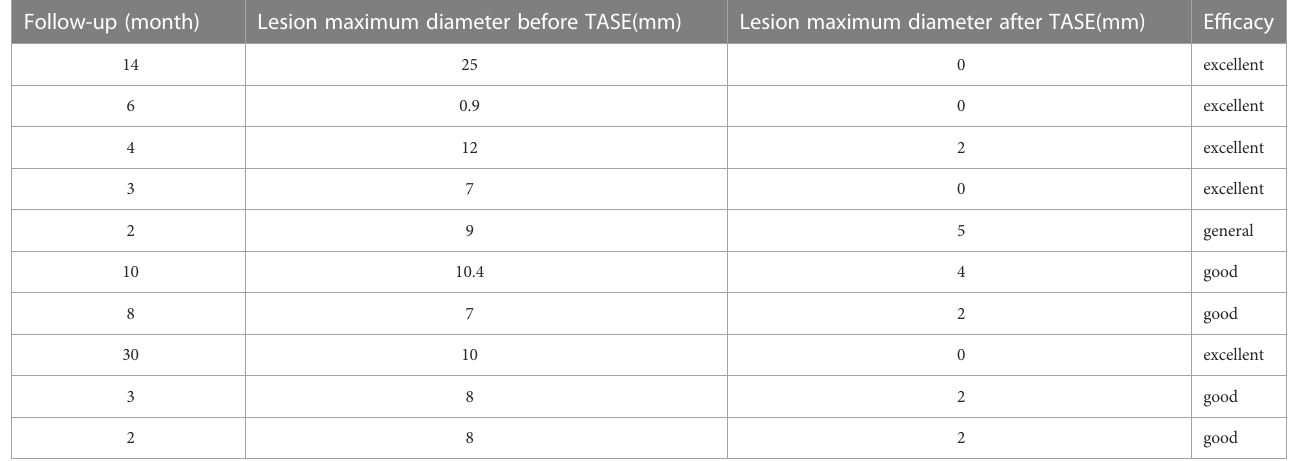
TABLE 1 Clinical Characteristics of the study patients. Follow-up